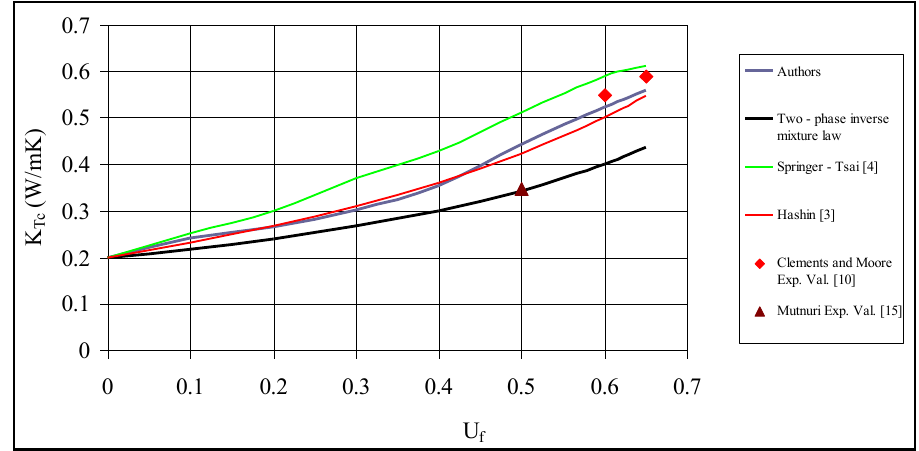
Figure 11. Theoretical values of transverse thermal conductivity versus filler content.